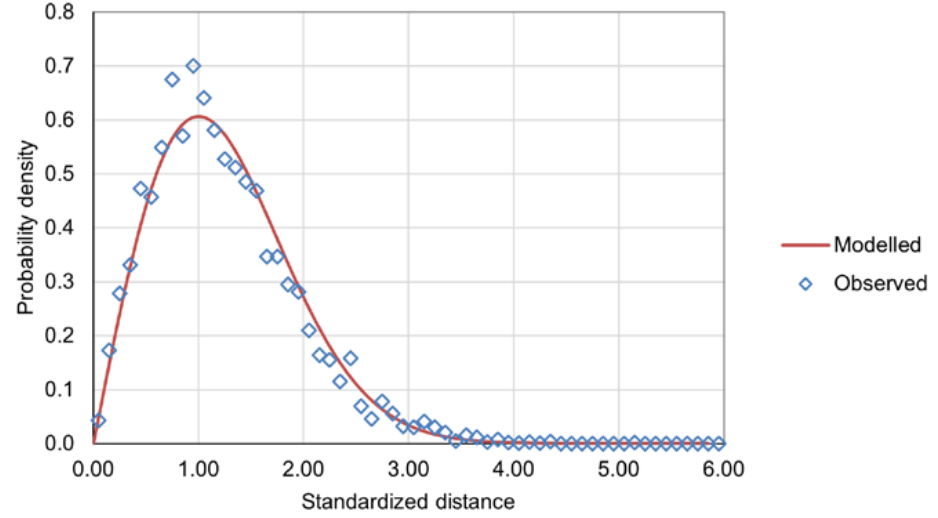
Figure 8. Distance test results: reconstruction of the distribution of the standardized triggering distance from observations versus the modelled distribution.